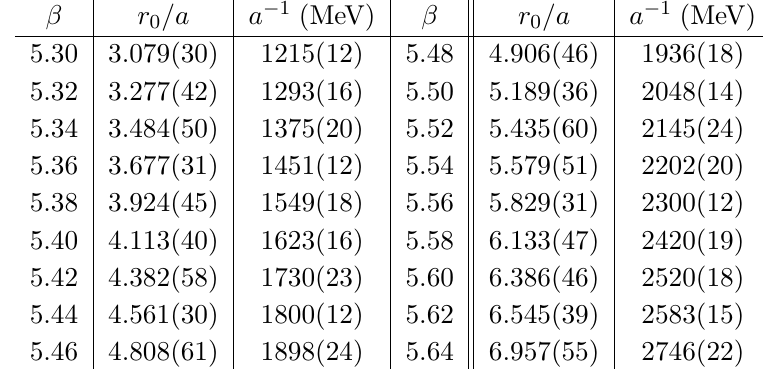
P n ν and U ( n ) = U † ( n − µ ) , V ν<µ − µ µ